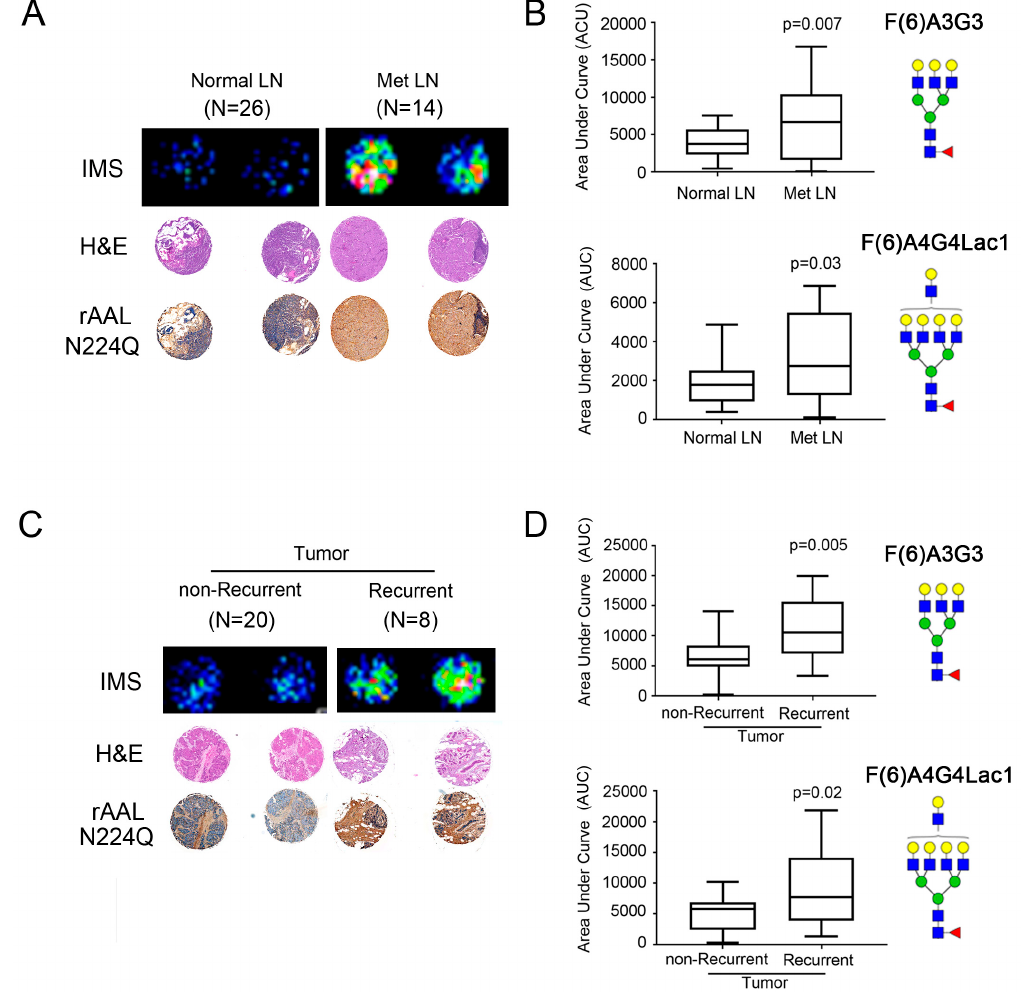
Figure 5. Increased fucosylation in metastatic lymph nodes (met LN) and tumors from recurrent patients. ( A ) A representative comparison of a patient with normal LN and met LN ( n = 33 patients) showed the increased distribution of fucosylated glycan (F(6)A4G4Lac1 shown here). The H&E stain was used to show the tumor region. Increased core fucosylation in met LN and tumors from patients with recurrence confirmed with lectin staining using rAALN224Q, a lectin with enhanced binding to core-fucosylated structures. TMA cores were imaged at 50 × magnification. ( B ) Statistically significant higher core fucosylated tri-antennary glycans (F(6)A3G3) and core fucosylated tetra-antennary with one lactosamine arm (F(6)A4G4Lac1) in the met LN samples ( p < 0.05). ( C ) A representative comparison of a patient with non-recurrent and recurrent tumors ( n = 33 patients) showed the increased distribution of fucosylated glycan by MALDI-IMS, with H&E staining, and confirmed with lectin staining using rAALN224Q. TMA cores were imaged at 50 × magnification. ( D ) Statistically significant higher core fucosylated tri-antennary glycans (F(6)A3G3) and core fucosylated tetra-antennary with one lactosamine arm (F(6)A4G4Lac1) in the met LN samples ( p < 0.05). 2.5. Core ‐ Fucosylated Tetra ‐ Antennary Polylactosamine Is Associated with Poor Survival